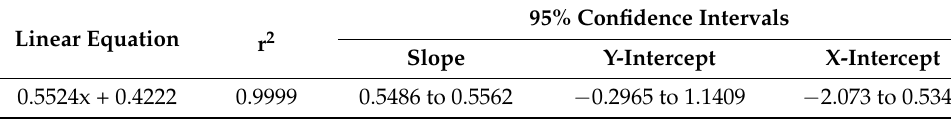
Table 1. Linear regression data for evaluation of linearity. Linear